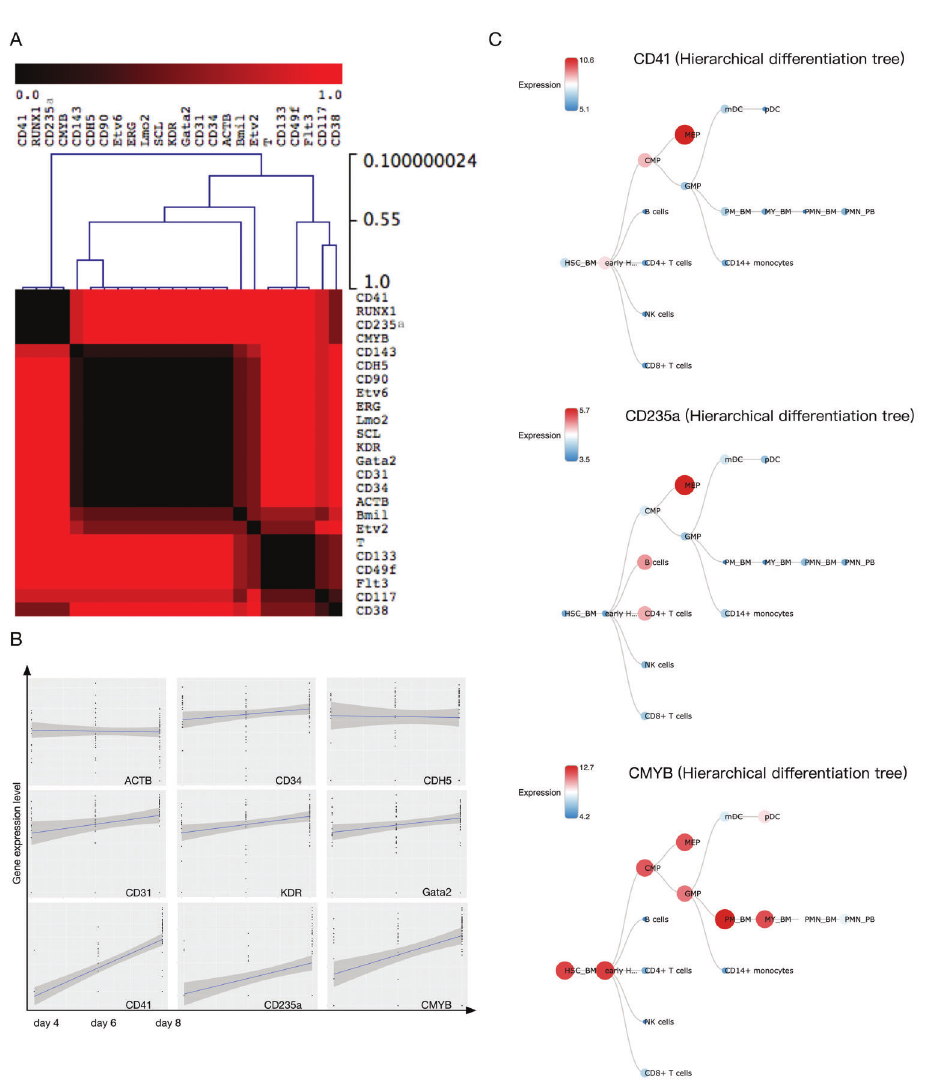
Figure 3. Gene-to-gene correlation shown by single-cell gene expression analysis. A, Heatmap of non-negative matrix factorization showing gene-to-gene correlation. The rank is 3. B, Gene expression (log2) trends from day 4 to day 8. ACTB , CD34, and CDH5 were stable. CD31 , KDR, and Gata2 increased gradually. CD41 , CD235a , and CMYB had a remarkable increase. C, Hierarchical differentiation tree of normal human hematopoiesis (HemaExplorer, BloodSpot) showing the relative expression of CD41 , CD235a , and CMYB in different blood cells. Blue to white suggests low to moderate gene expression (log2) and white to red suggests moderate to high gene expression (log2). MEP: megakaryocyte-erythroid progenitor